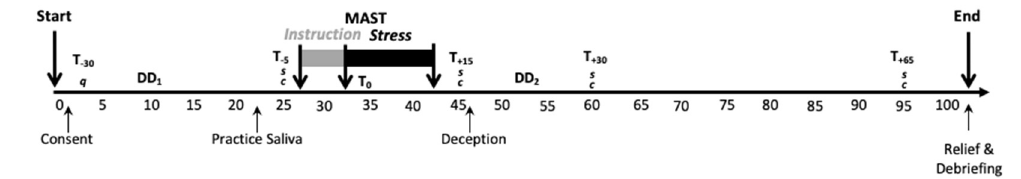
Figure 1. A detailed timeline of the stress experimental session. DD—delay discounting task; MAST—Maastricht acute stress test; q STAI-T—state and trait anxiety inventory, BIS—Barratt impulsiveness scale and PSS—perceived stress scale; s PANAS—positive and negative affect and VAMS—visual analogue mood scale; c Cortisol.